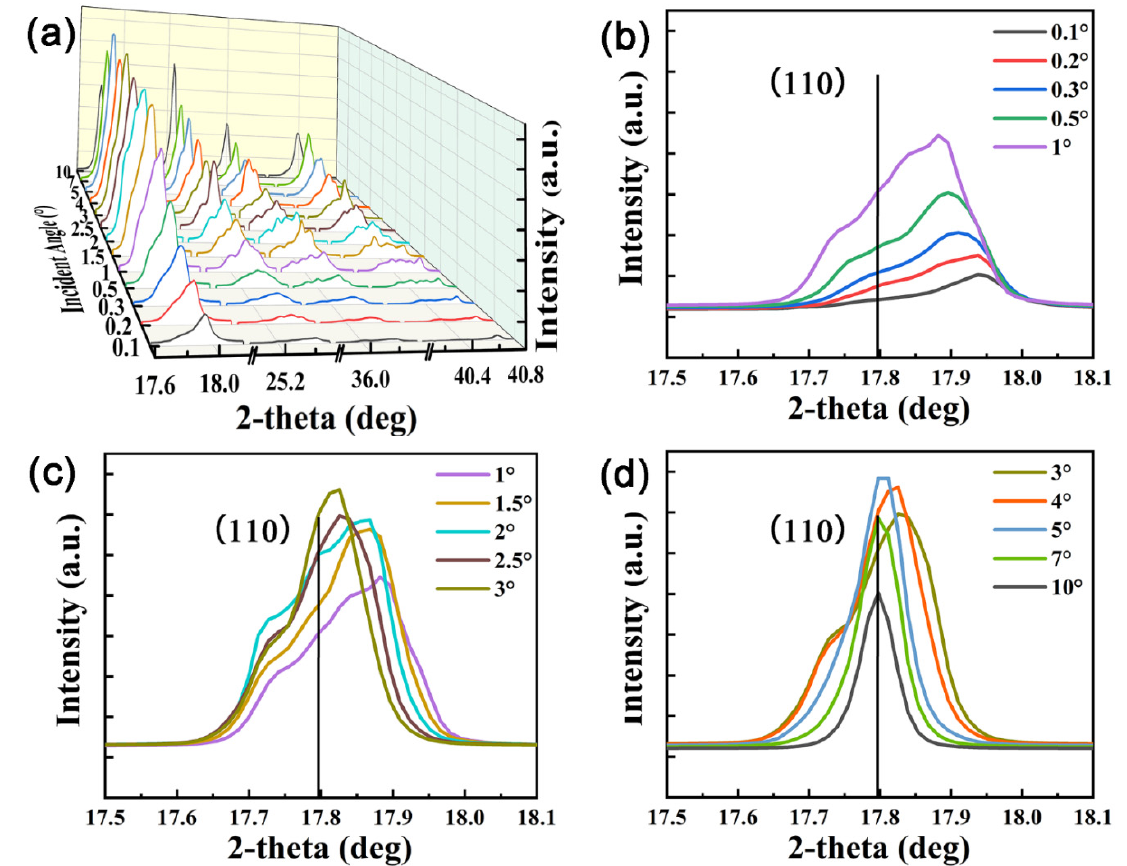
Figure 2. ( a ) S-GIXRD patterns of 2 × 10 21 He ions/m 2 irradiated W at different incident angles. The enlarged (110) peaks at incident angles of ( b ) 0.1–1°, ( c ) 1–3°, and ( d ) 3–10°.